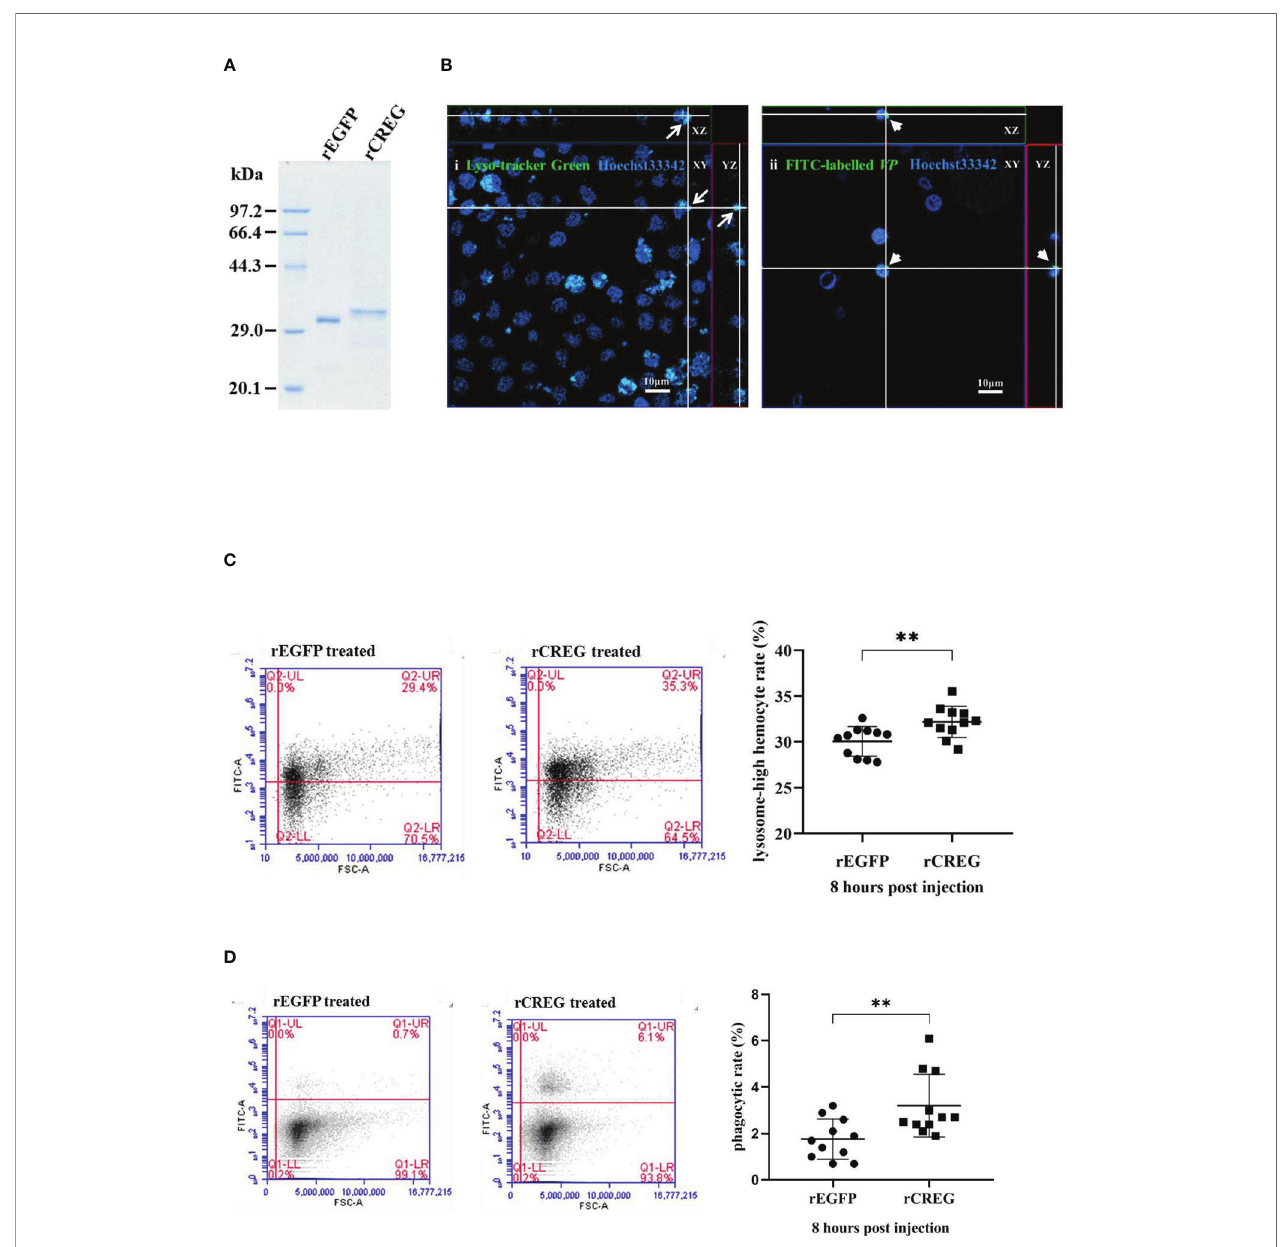
FIGURE 3 | Recombinant shrimp CREG protein induces hemocyte differentiation. (A) SDS-PAGE of puri fi ed rEGFP and rCREG. (B) Confocal microscopy observation of lysosome-labeled (green) (i) and FITC-VP-phagocytized (green) (ii) hemocytes with Hoechst 33342 (blue)-stained nuclei. Labeled lysosomes are indicated by arrows, and phagocytized FITC-VPs are indicated by arrow heads. (C) Lysosome high hemocyte proportion of total hemocytes extracted from rEGFP- (control) and rCREG-treated shrimp. Left, the representative scatter plot for the rEGFP-treated shrimp. Middle, the representative scatter plot for the rCREG-treated shrimp. Right, each dot represents the test result of one shrimp. (D) The phagocytic activity of total hemocytes extracted from rEGFP + FITC VP-treated shrimp and rCREG + FITC VP-treated shrimp. Left, the representative scatter plot for rEGFP + FITC VP-treated shrimp. Middle, the representative scatter plot for the rCREG + FITC VP-treated shrimp. Right, each dot represents the test result of one shrimp. Each dot represents the test result of one shrimp, ** p < 0.01 was calculated by two-tailed unpaired Student ’ s t -tests compared with the